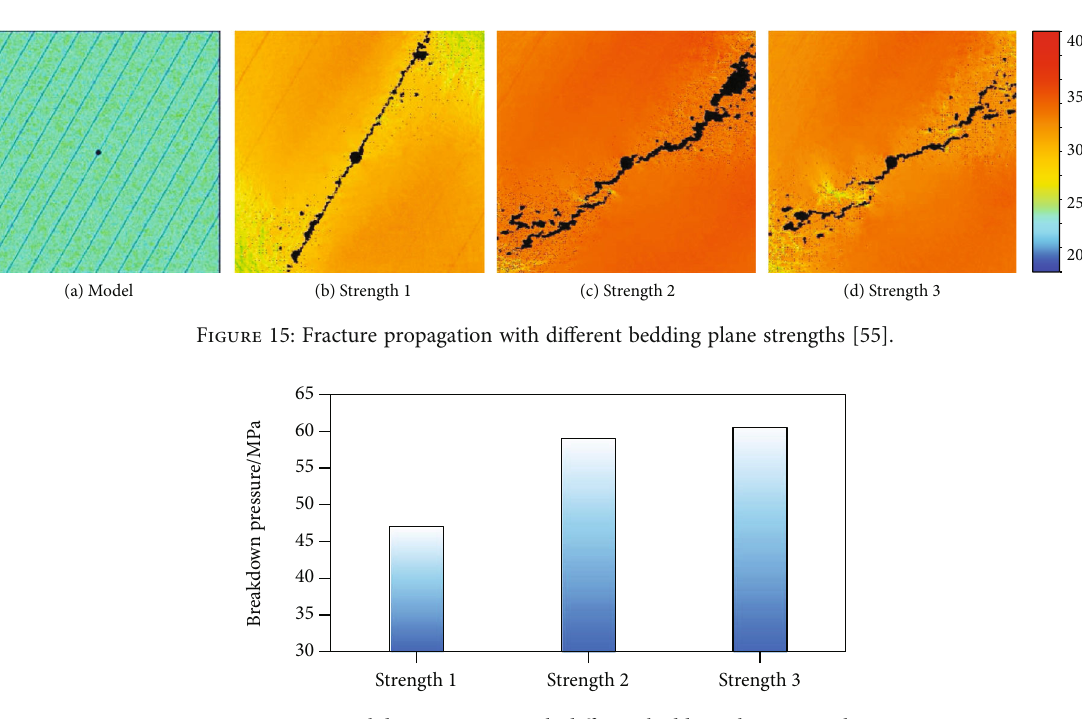
Figure 16: Breakdown pressure with di ff erent bedding plane